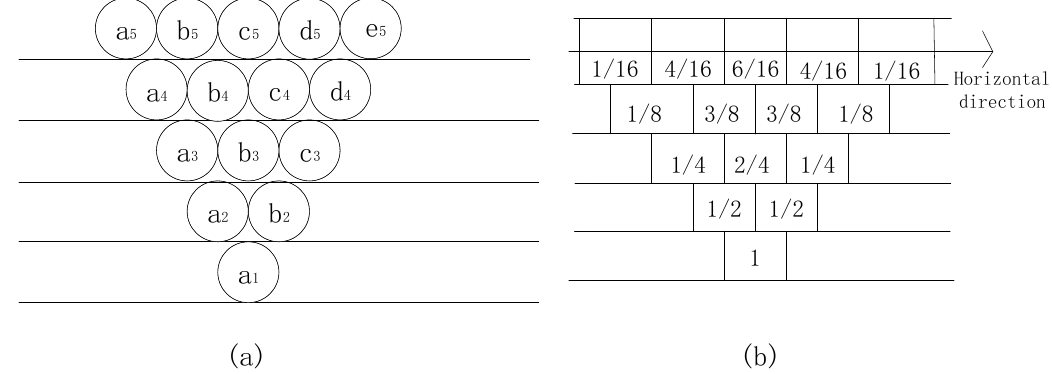
Figure 1. Theoretical model of particulate medium; ( a ) theoretical model and ( b ) distribution of particulate movement